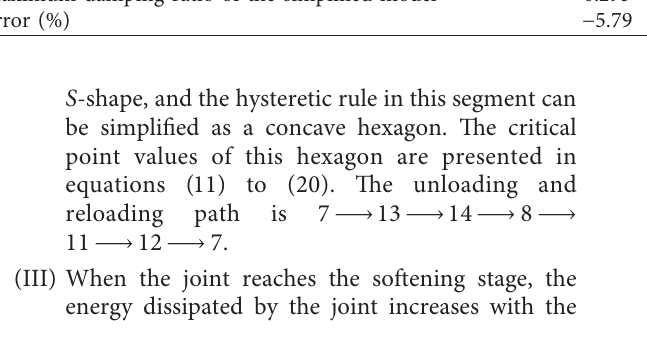
Figure 19: Comparison between the hysteretic curve obtained from the experimental and the simplified model: (a) J -6-1; (b) J -8-1; (c) J -8-2; (d) J -8-3. Table 12: Comparison of the damping ratio between the test and simplified model. Specimen J -6-1 Maximum damping ratio of the test 0.311 0.292 Maximum damping ratio of the simplified